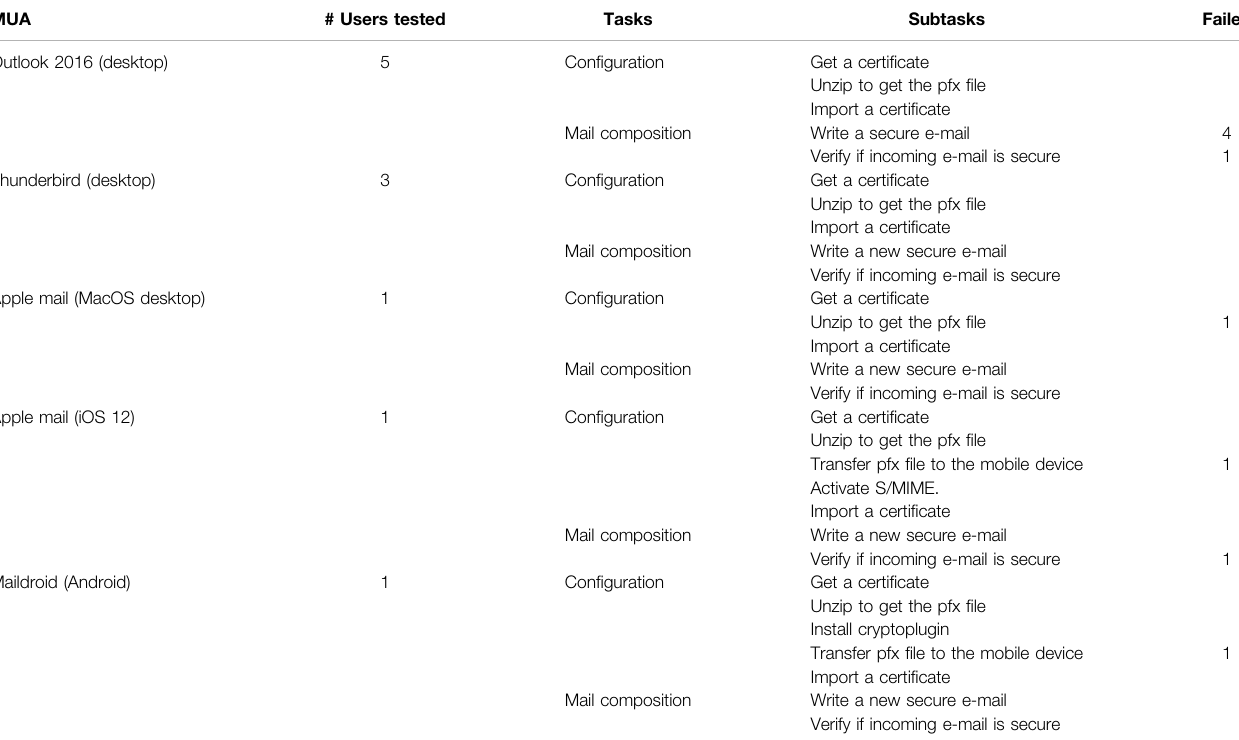
TABLE 8 | User testing results for S/MIME regarding the number of users who tested an MUA and who failed for a speci fi c sub-task. MUA # Users